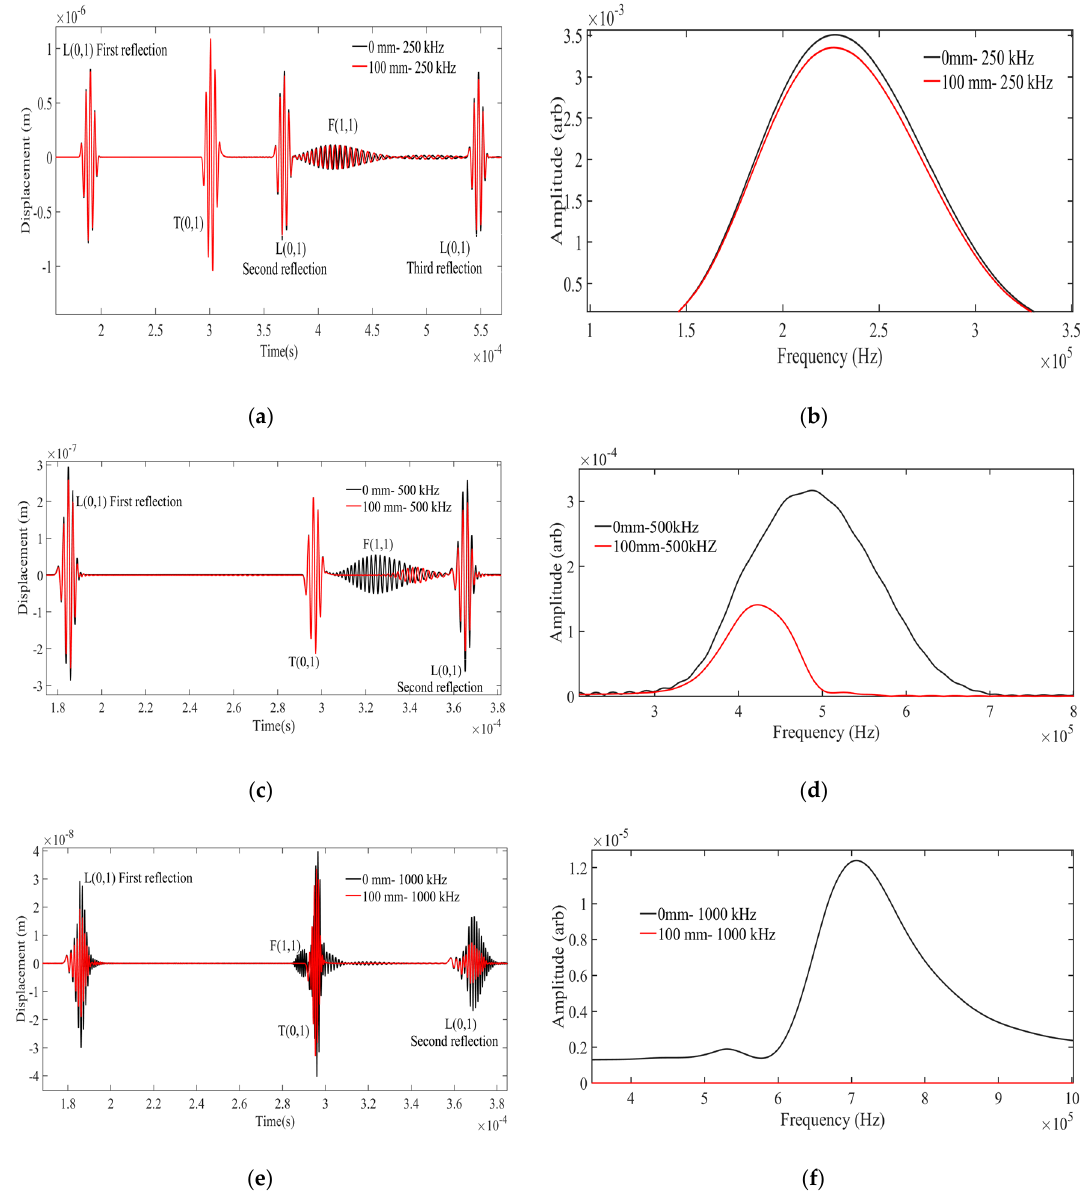
Figure 6. A-Scan signals at the frequencies of ( a ) 250 kHz, ( c ) 500 kHz, and ( e ) 1000 kHz at a 45° angle of excitation and their corresponding FFT plots of F(1,1) at ( b ) 250 kHz, ( d ) 500 kHz, and ( f ) 1000 kHz. Table 2. Response of three-wave mode to inviscid fluid loading at different operating frequency regimes.